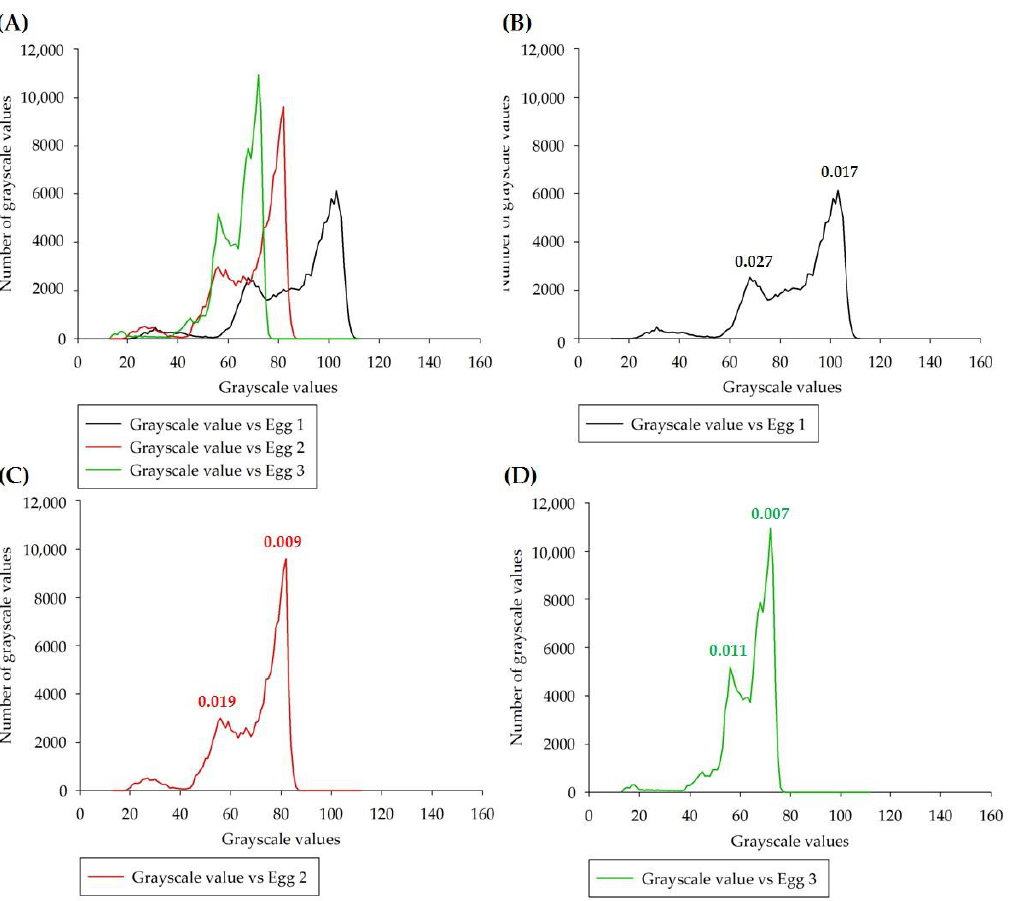
Figure 9. The results of the gray-scale density distribution curves from radiography visualization for the yolk and albumen of eggs of three different qualities in the median plane directions. ( A ) Comparison of shell quality curves of eggs of three different qualities, ( B ) SO egg (Egg 1) (black line), ( C ) GO egg (Egg 2) (red line), and ( D ) CO egg (Egg 3) (green line).